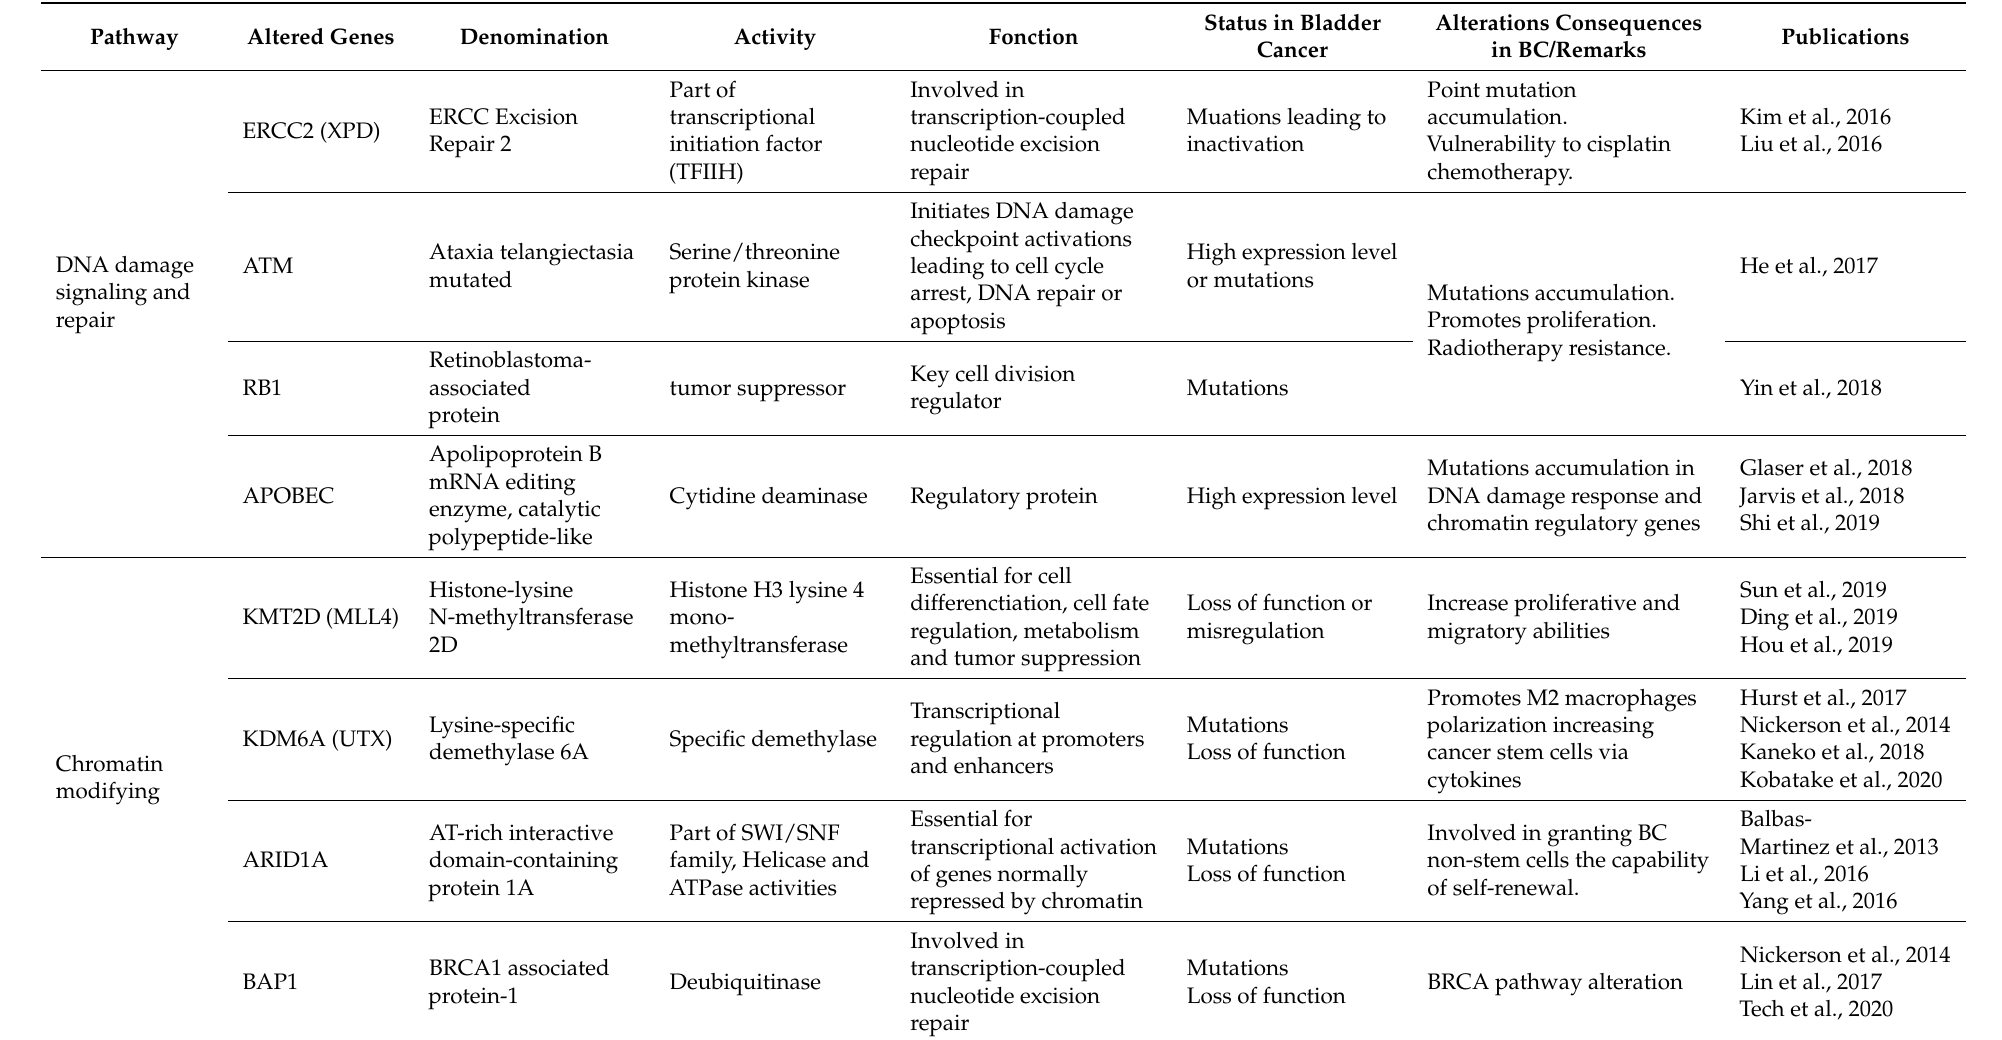
Table 1. Genes altered in BC and used to develop urine-based diagnostic